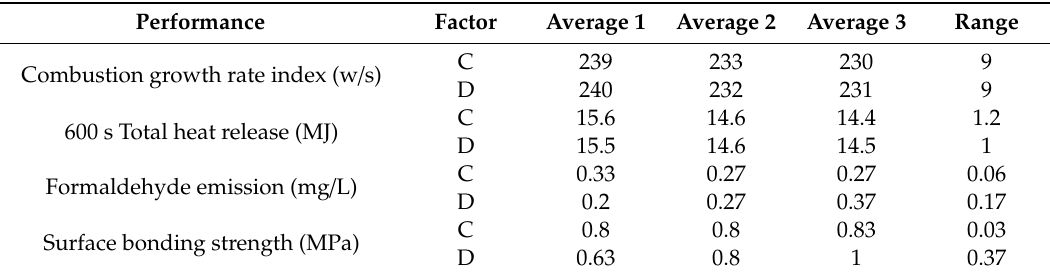
Table 7. Range analysis of two-time sizing optimization